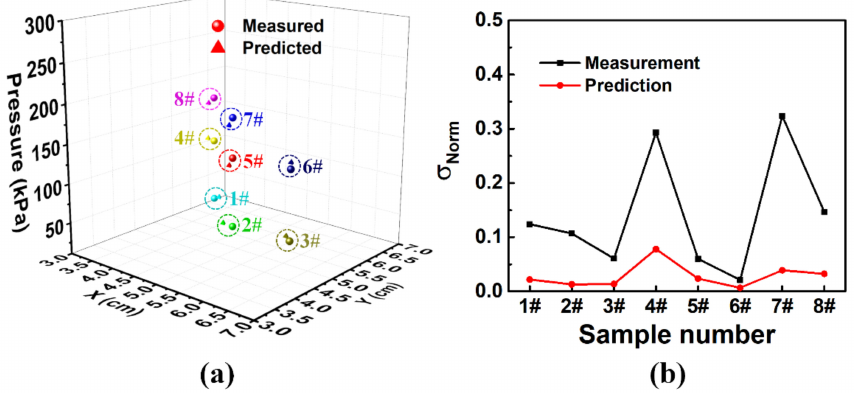
Figure 6. ( a ) Three-dimensional mapping of the predicted and measured results of 8 typical data samples. ( b ) Normalized standard deviations of measurements and predictions of 8 typical test